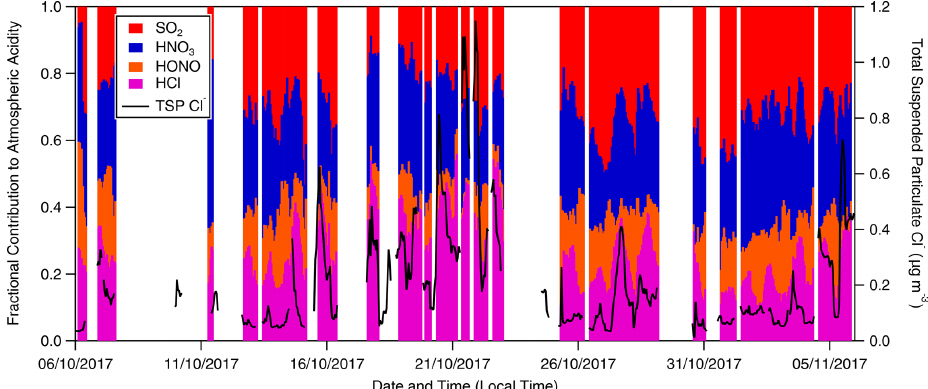
Figure 10. Fractional contribution to total measured inorganic acidity from SO 2 , HNO 3 , HONO and HCl as measured by GRAEGOR at 60m (hourly resolution). The concentration of inorganic particulate Cl − is included as an indicator of periods when sea salt or chloride containing particulate was present at the ATTO